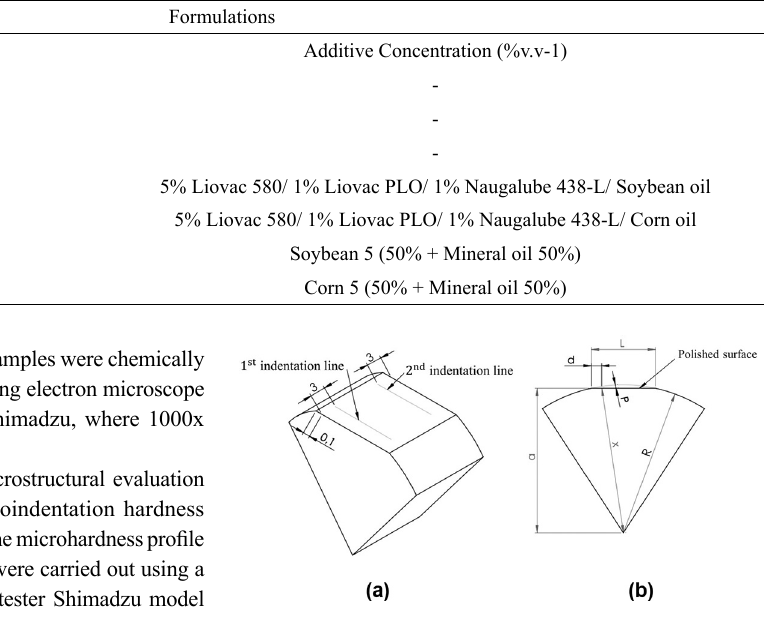
Figure 1. Microhardness profile measurement: indentation lines (a) and geometric relations to calculate the depth of indentation (b).